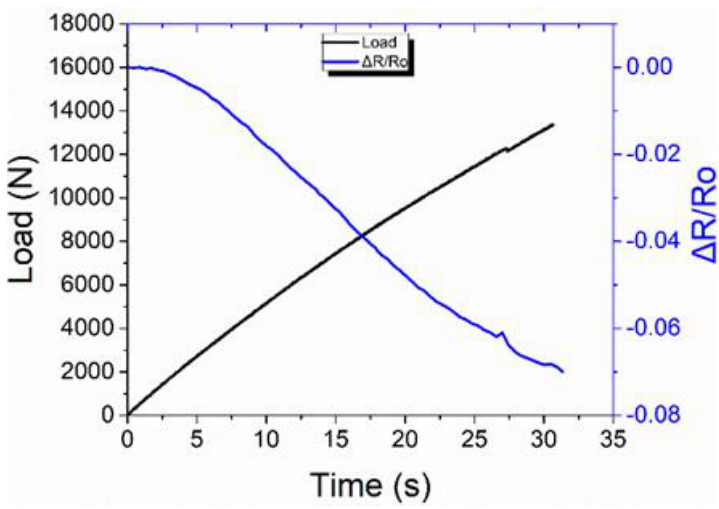
Figure 28. Representative lap strap test of the 3R composite with ERCM monitoring.